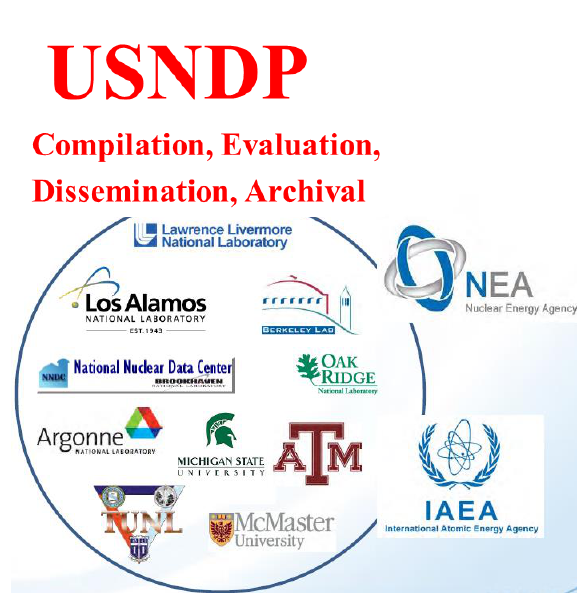
Figure 1. USNDP evaluation centers (inside the circle) together with the two international institutions of which IAEA assumes the international coordination role. The main goals of the US- NDP are also listed at the top.